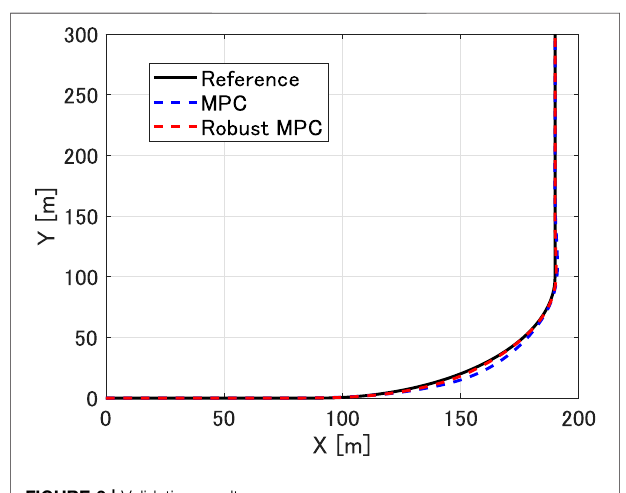
FIGURE 3 | Validation